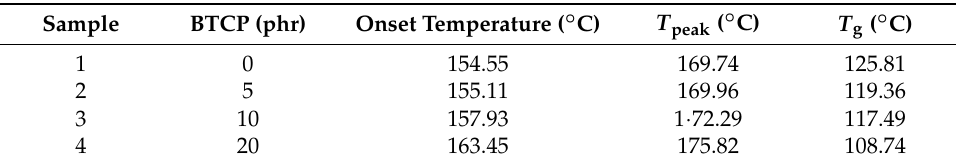
Table 3. DSC data of epoxy/BTCP compositions.